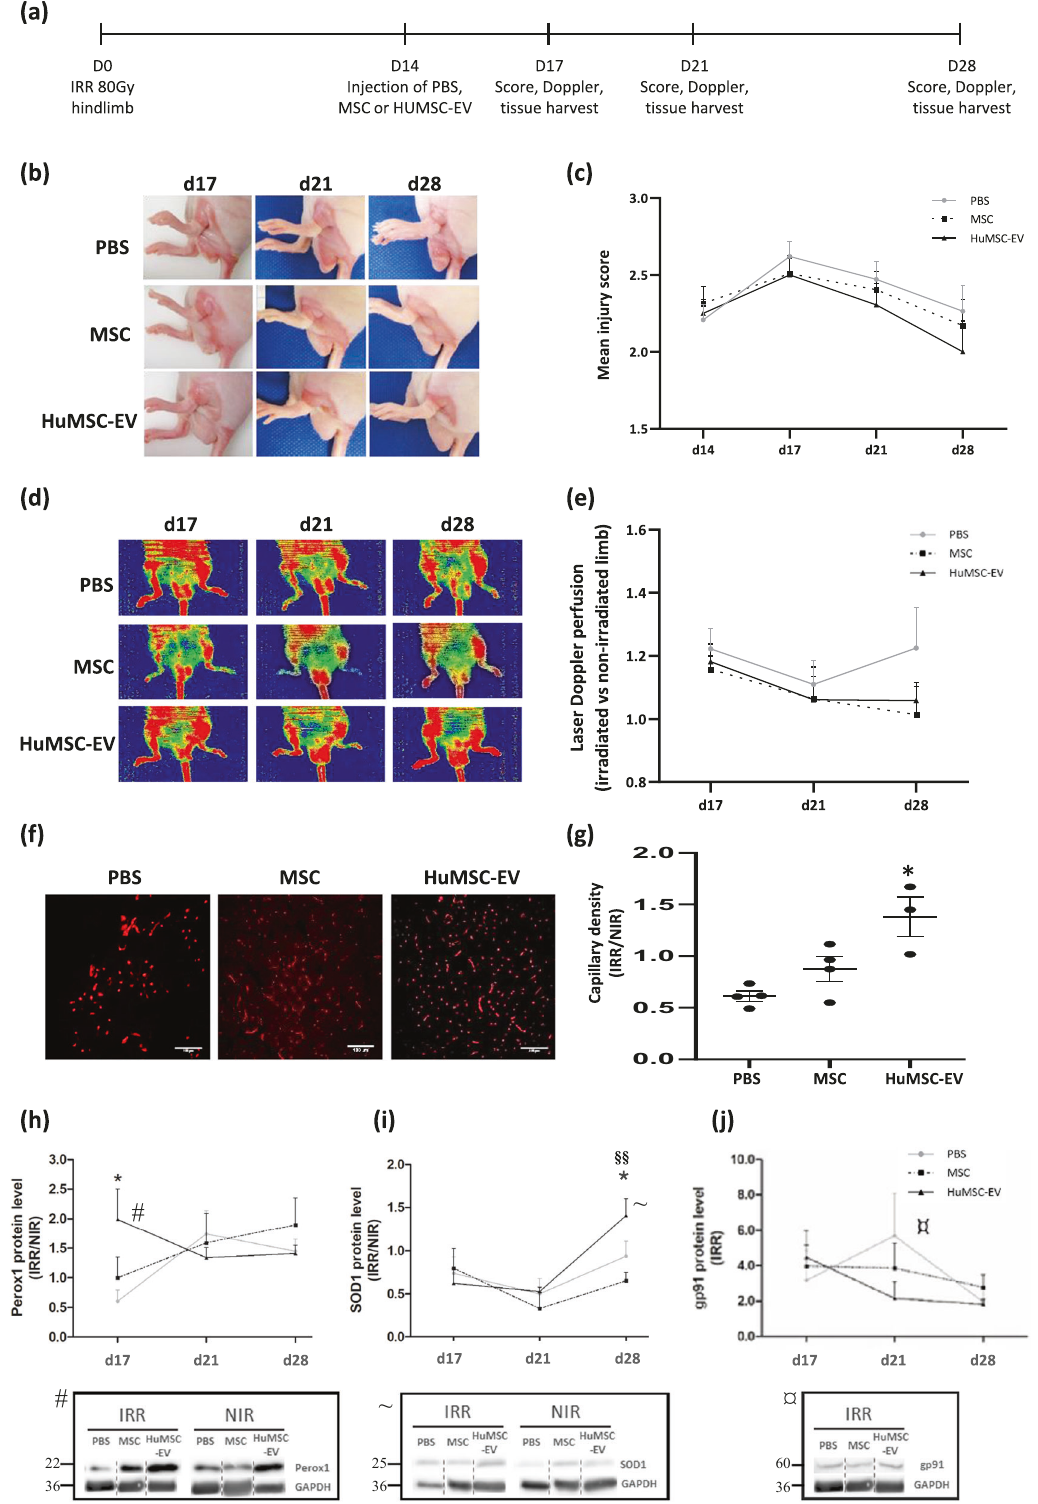
cells and dermal fi broblasts (see Supplementary Fig. S2 online), as compared to PBS control. Interestingly, treatment with the PI3K/AKT inhibitor LY294002 signi fi cantly inhibited HuMSC-EV-mediated effect on both endothelial cells ( P < 0.001) and fi broblasts ( P < 0.01). Surprisingly, the TGF- β /SMAD2 inhibitor SB431542 signi fi